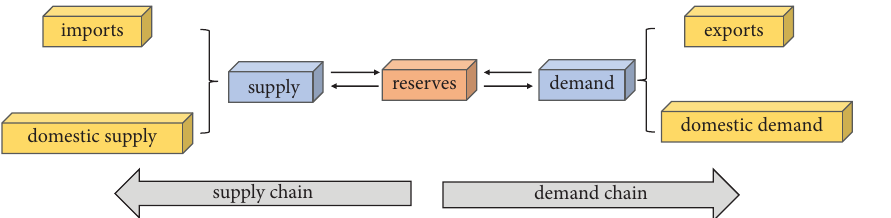
Figure 1: Relationship between supply chain, demand chain, and reserve of mineral resources